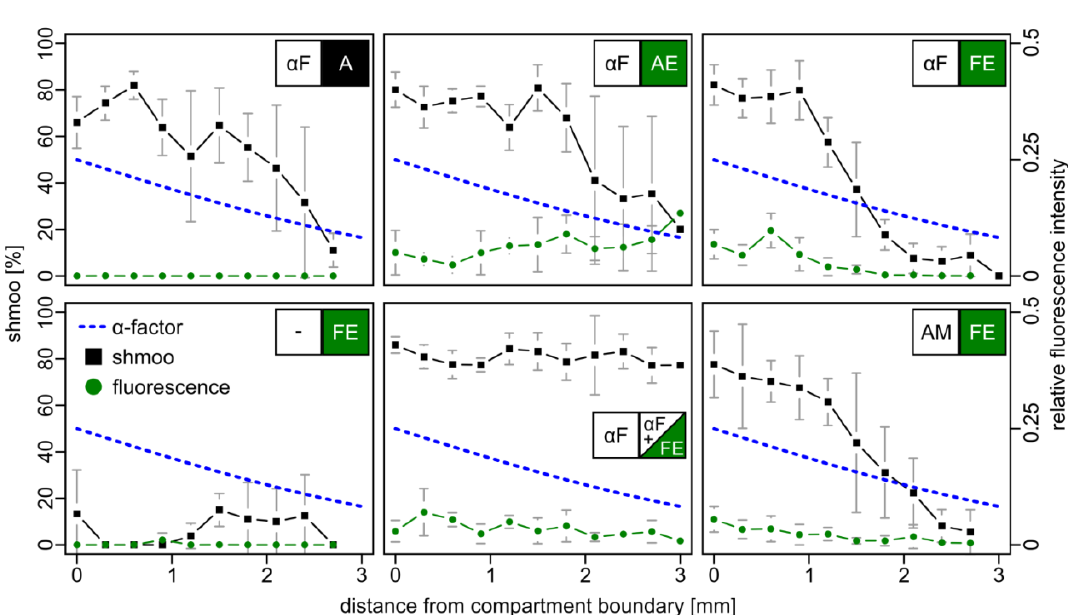
Figure 3. Spatial trend of shmoo and fluorescence induction in a two-compartment setup. BY4741 bar1 Δ reporter cells (FE, see Table 1 for identifiers) and a source of α–factor (αF) were immobilized in two adjacent compartments on microscope slides and incubated for six hours prior to analysis. The percentage of shmoo-displaying cells and the average fluorescence intensity for indicated populations at different distances from the compartment containing the source of α–factor is given. The dashed line marks modeled α–factor concentration (see supplementary data). A value of 100% corresponds to the initial concentration of 10 µM. Mean values ± standard deviations from three experiments are